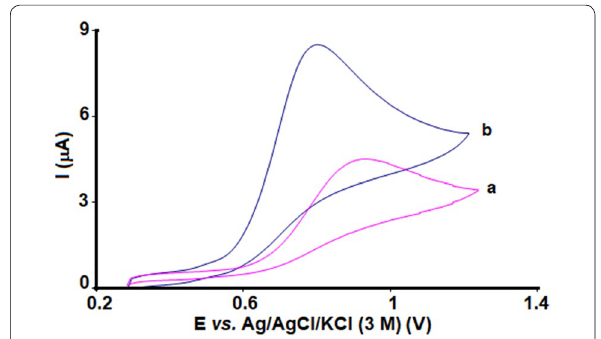
Fig. 1 CVs of (a) unmodified SPE and (b) MCSNP/SPE in the presence of 90.0 µM ACh at pH 7 (at 5 mV s − 1 )